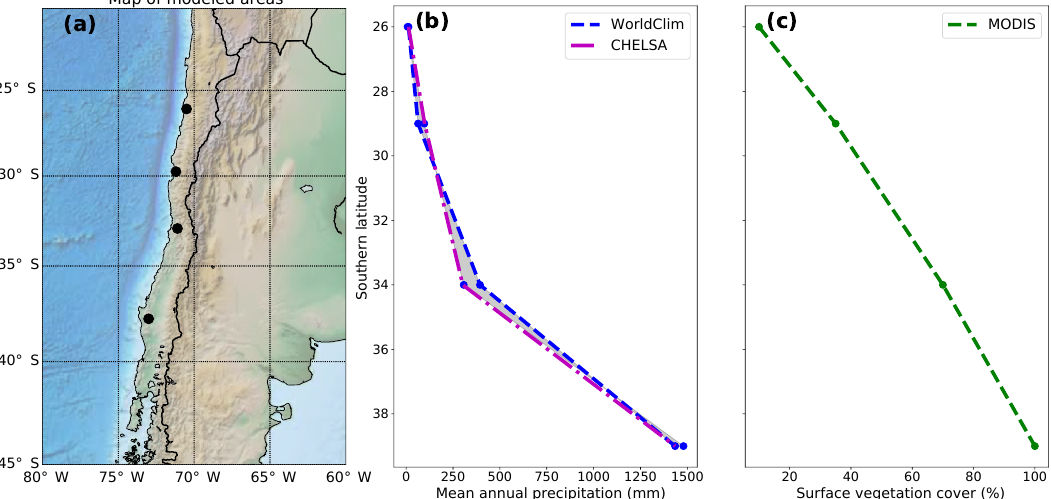
Figure 1. Overview of the geographic location, precipitation, and vegetation cover of the Chilean Coastal Cordillera study areas used for the model setup. (a) Digital topography of the areas considered in this study, which correspond to the EarthShape (https://www.earthshape.net) focus areas where ongoing related research is located. (b) Observed present-day mean annual precipitation from the WorldClim and CHELSA datasets used as model input. (b) Present-day maximum surface vegetation cover from MODIS